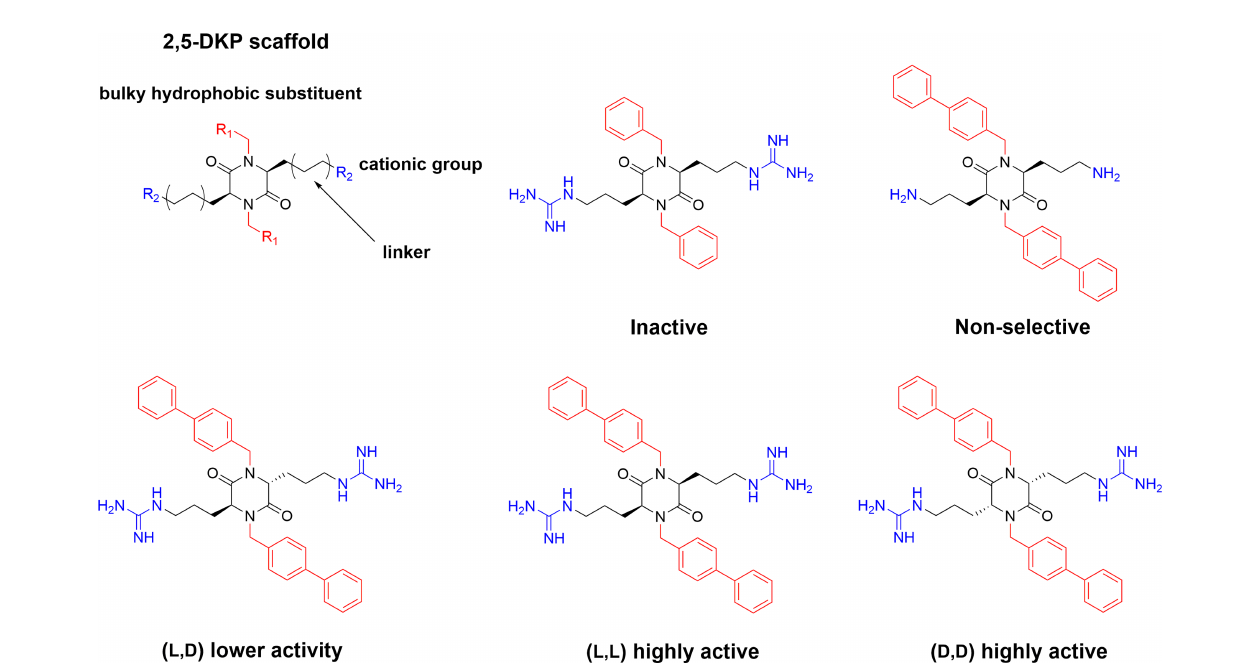
FIGURE 6 | Design of the antimicrobial 2,5-DKP scaffold where the functionalities required for potent bioactivity can readily incorporated. Recent studies report a similar pharmacophore as that described for linear peptides for the shorter cyclic dipeptides (65). Bottom row illustrate stereoisomers of cyclo( N -Bip-Arg- N -Bip-Arg) which display difference in bioactivity due to their ranging ability to form stable amphiphilic solution structures